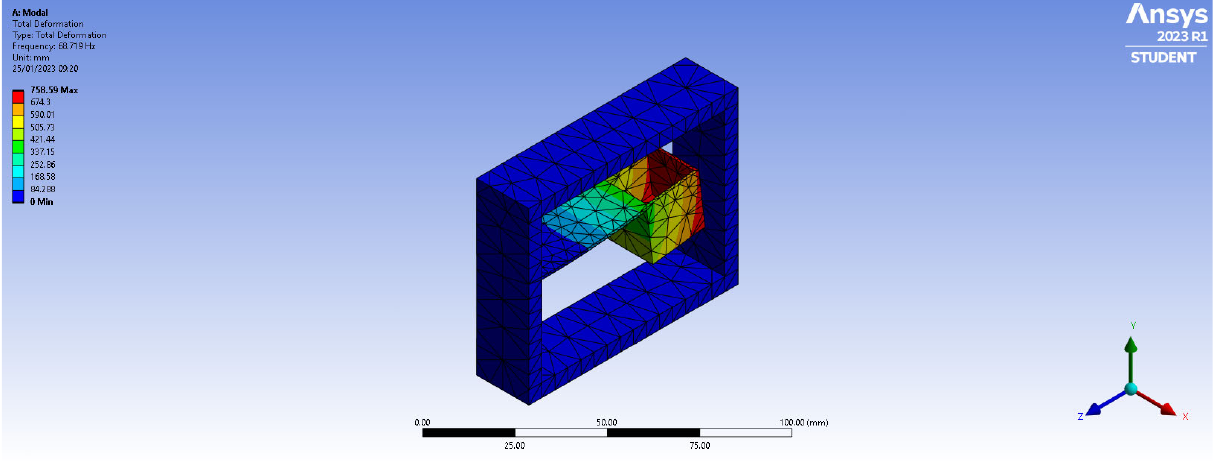
Figure 6. First vibration mode in modal analysis for system configuration having cantilever length of 40 mm, thickness of 1 mm, and breadth of 20 mm. Table 3. First six resonance frequencies (Hz) obtained for the system configuration of Figure